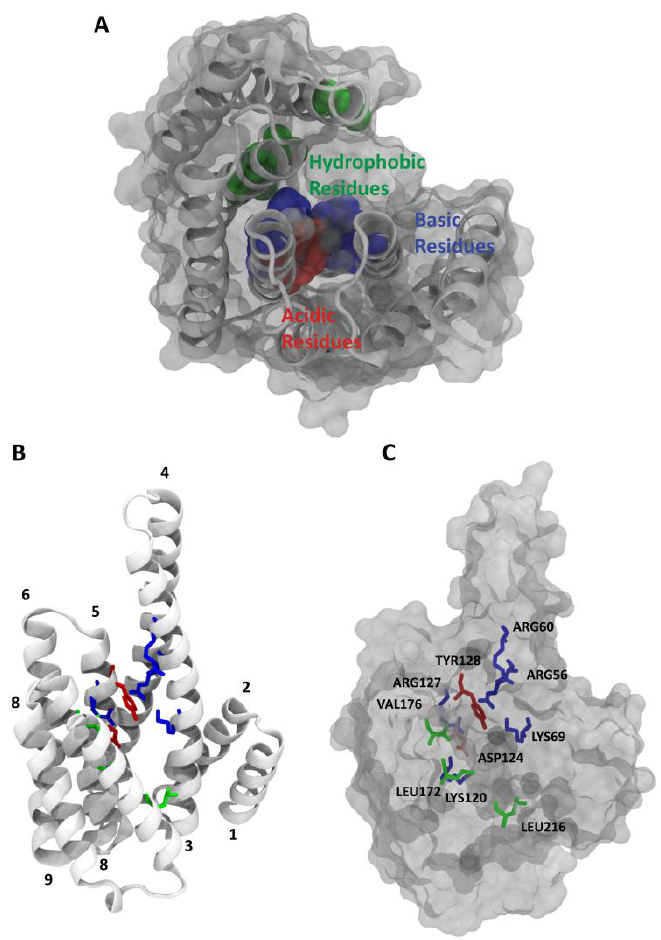
Figure 1. View of the monomer of the 14-3-3 ζ isoform (PDB ID: 5EXA) [11] ( A ). The molecular assembly of the structural elements is shown in cartoon and surface representation. Hydrophobic, basic and acidic residues are depicted in green, blue, and red, respectively ( B , C ). View of the monomer turned by 90 degrees around the y-axis; helices from 1 to 9 constituting the classical 14-3-3 monomer are represented, as well as residues that belong to the phospho-acceptor side and residues that establish the hydrophobic interactions.